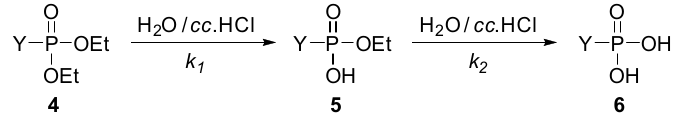
For the Y substituents see Table 2. Scheme 2. The two-step hydrolysis of other phosphonate derivatives. Table 2. Experimental and kinetic data on the two-step hydrolysis of phosphonates 4k – m .